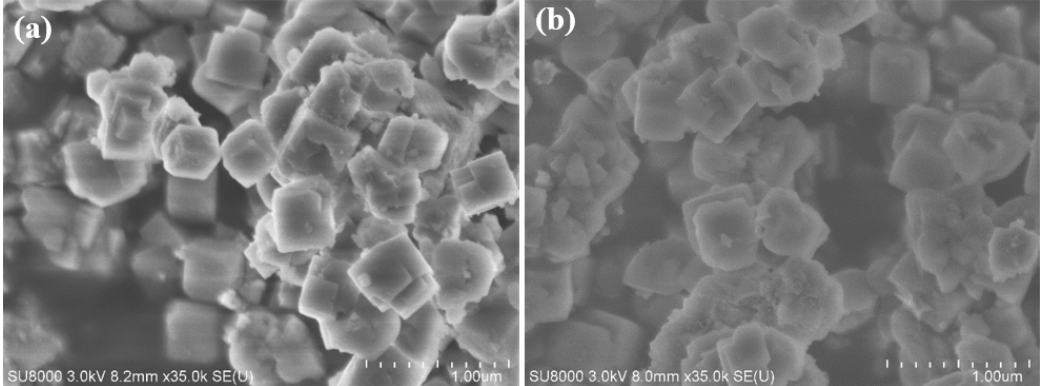
Figure 2. SEM images of ( a ) Cu-SSZ-13 and ( b ) 5% Mn/Cu-SSZ-13.